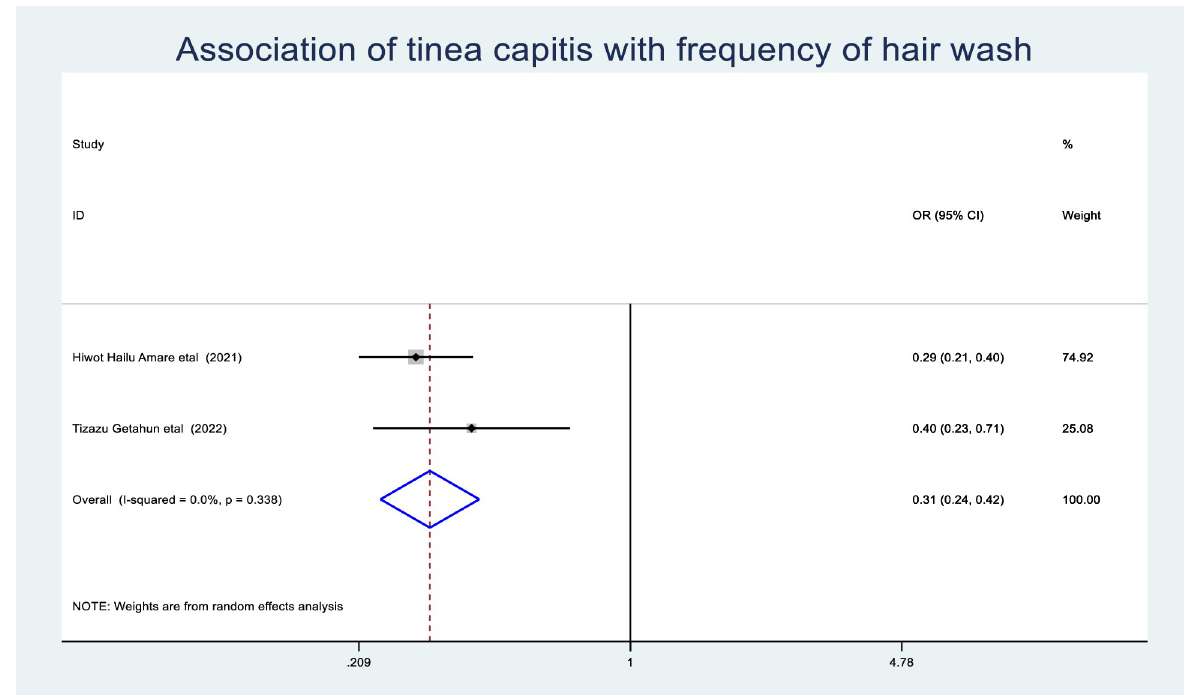
Fig 10. Association of tinea capitis with family history of schoolchildren.